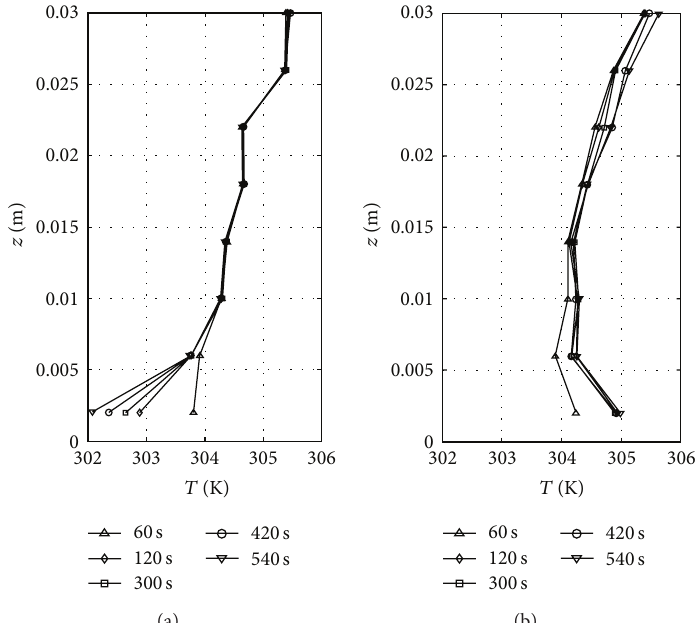
Figure 26: Temperature profiles in the middle of the slope for the katabatic case (left-hand side) and the anabatic case (right-hand side).